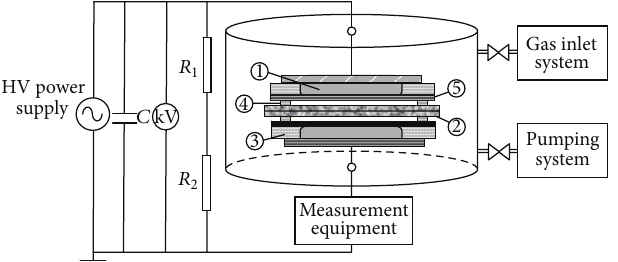
Figure 1: Experimental setup of the DBD treatment: (1) metal electrodes, (2) sample, (3) plexiglass rings, (4) gaskets, and (5) dielectric barrier.